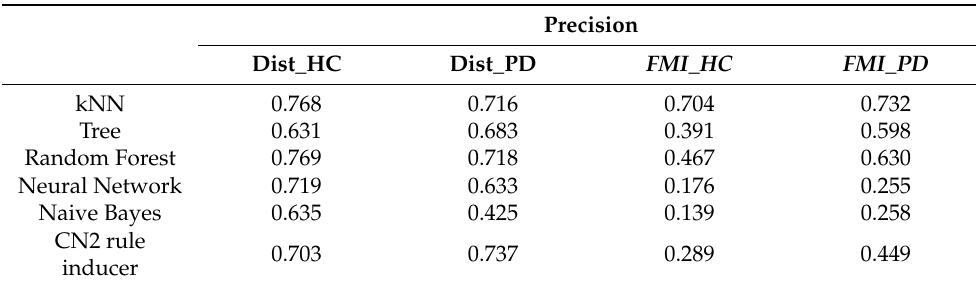
Table A1. Precision. Dist_HC and Dist_PD refer to the dataset of normalized distances with the preprocessing step of PCA whereas FMI_HC and FMI_PD refer to the FMI dataset.